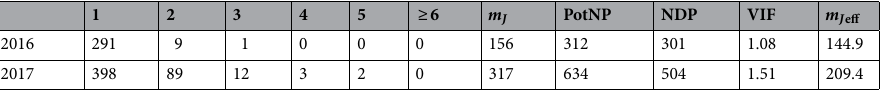
Table 3. Number of Distinct-Parent-Groups, g s , by size s (i.e., number of offspring in the group), plus summary statistics.